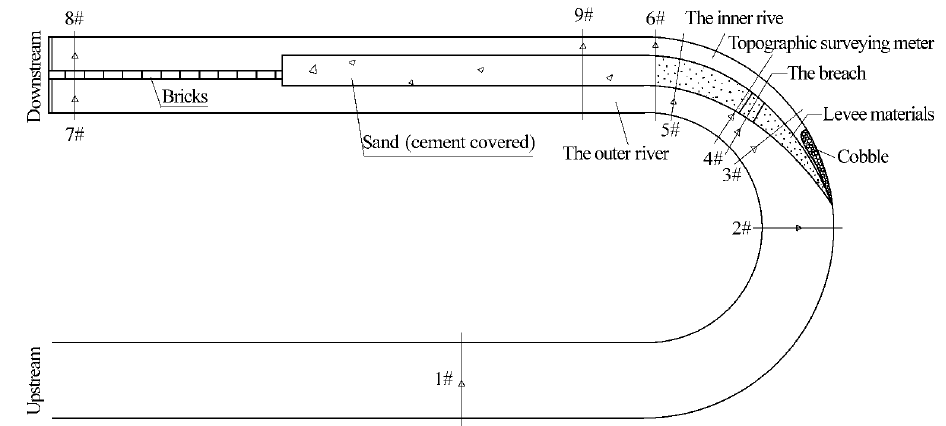
Fig. 3. Sketch of the experiment layout.